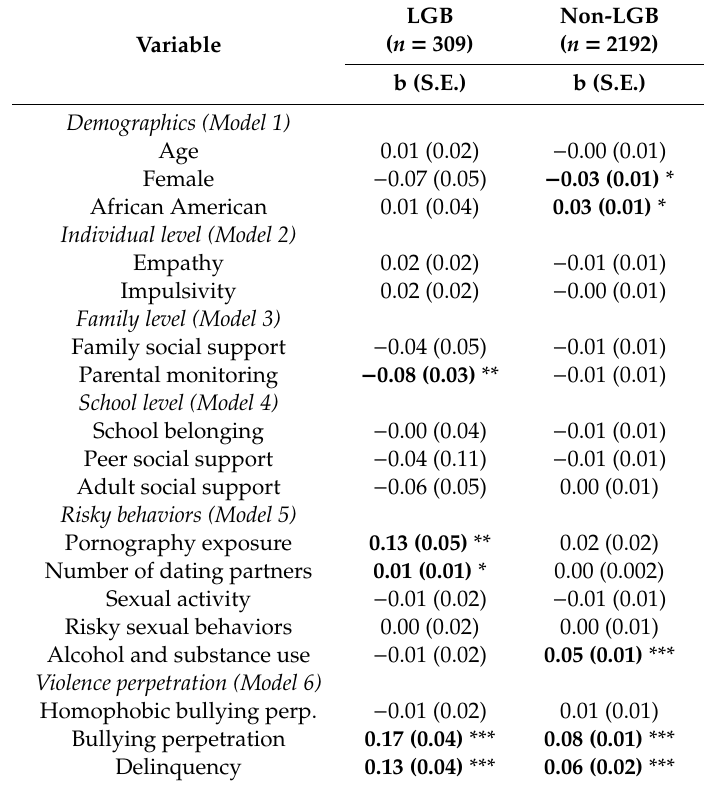
Table 2. Results of structural equation models, outcome sexting perpetration. 1